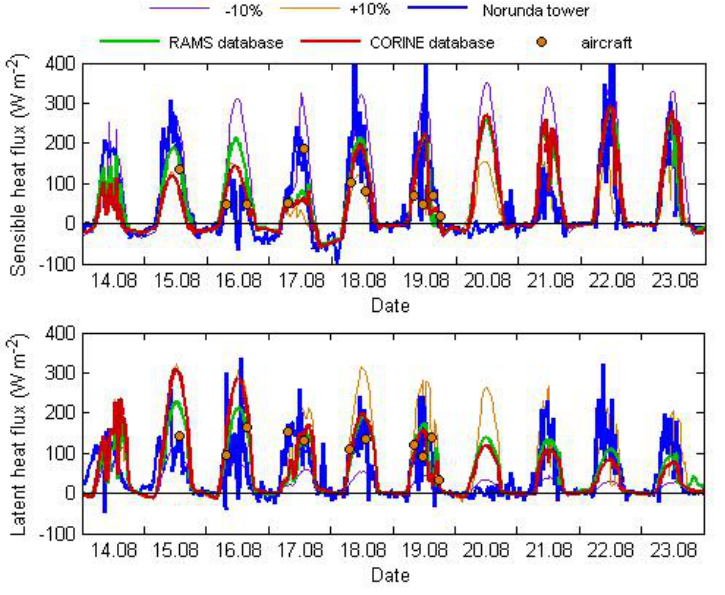
Figure 8. Measured and simulated sensible heat flux ( upper ) and latent heat flux ( lower ) for the ten-day period in August 2001. The thin lines in the figure represent simulation with +10% respectively − 10% lower initial values of soil